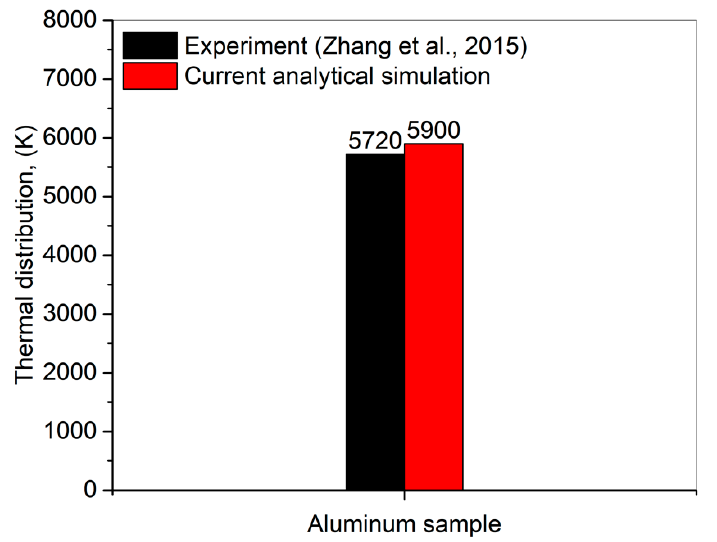
Figure 1. Thermal distribution for a single pulse comparison between the current analytical simula- tion model and experimental [23] results. tion model and experimental [23]